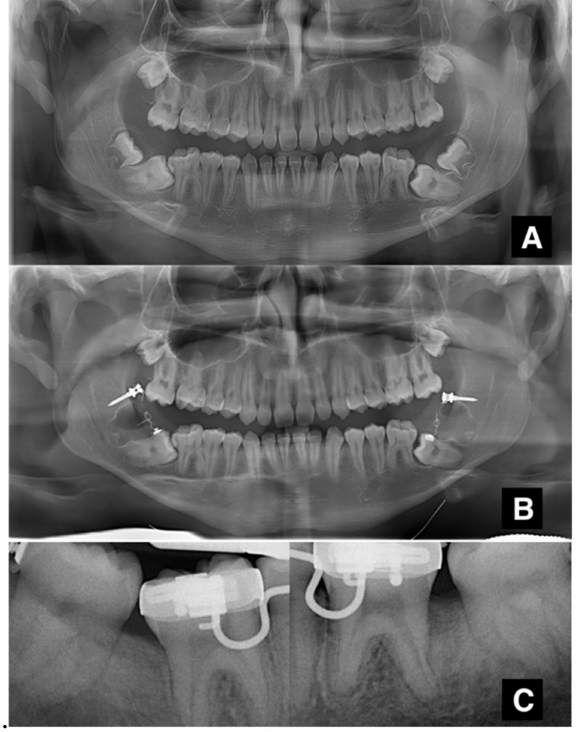
Figure 3. ( A – C ) Radiographic sequence of a rare bilateral